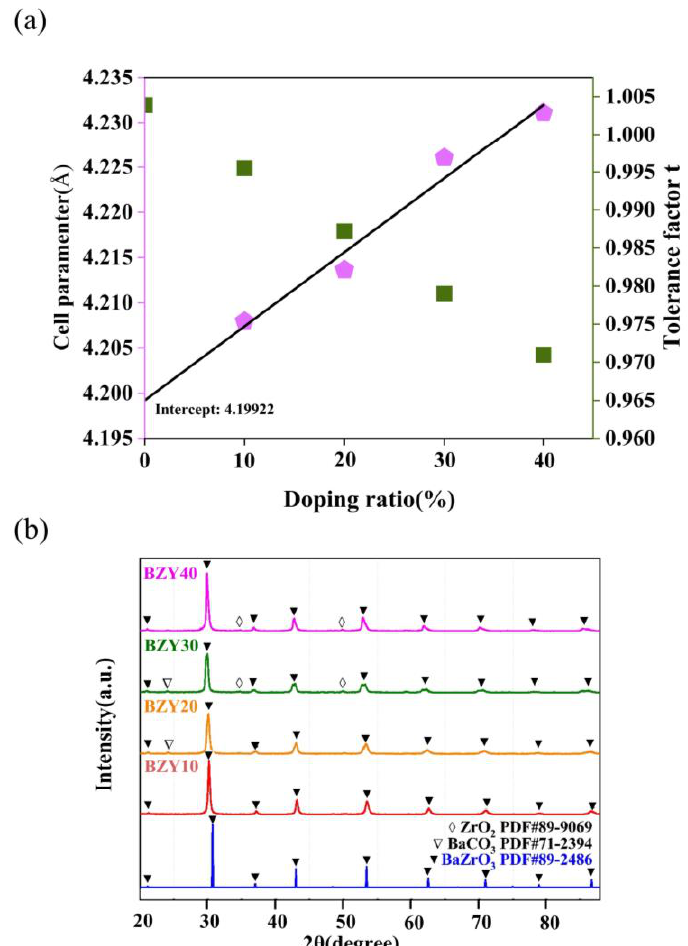
Figure 10. ( a ) Relationship between the calculated lattice parameter and the yttrium content for BZYs. ( b ) XRD patterns of calcined BZYs powders.